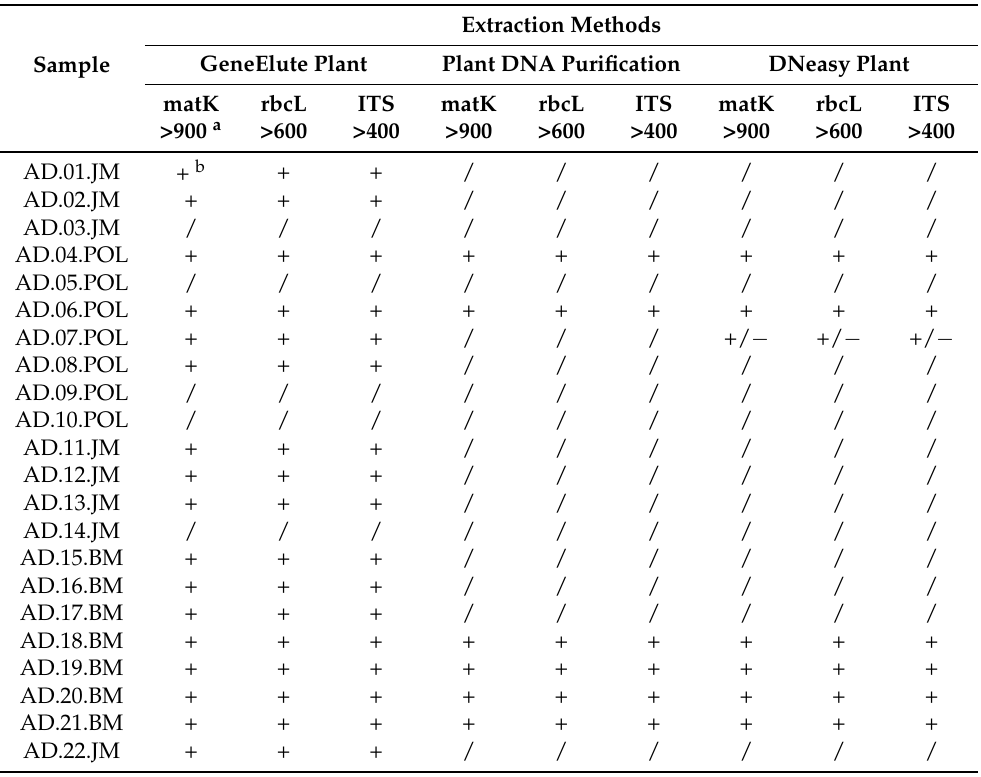
Table 3. Results of the amplificability tests with the universal primers for plant barcoding on the extractions carried out with the three